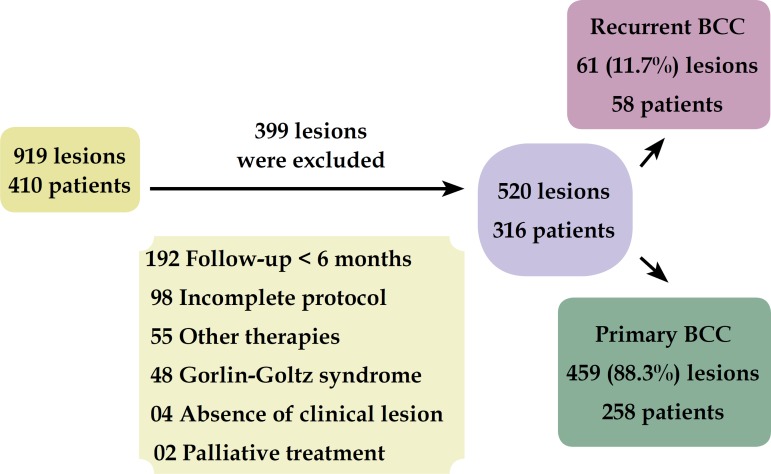
Exclusion criteria